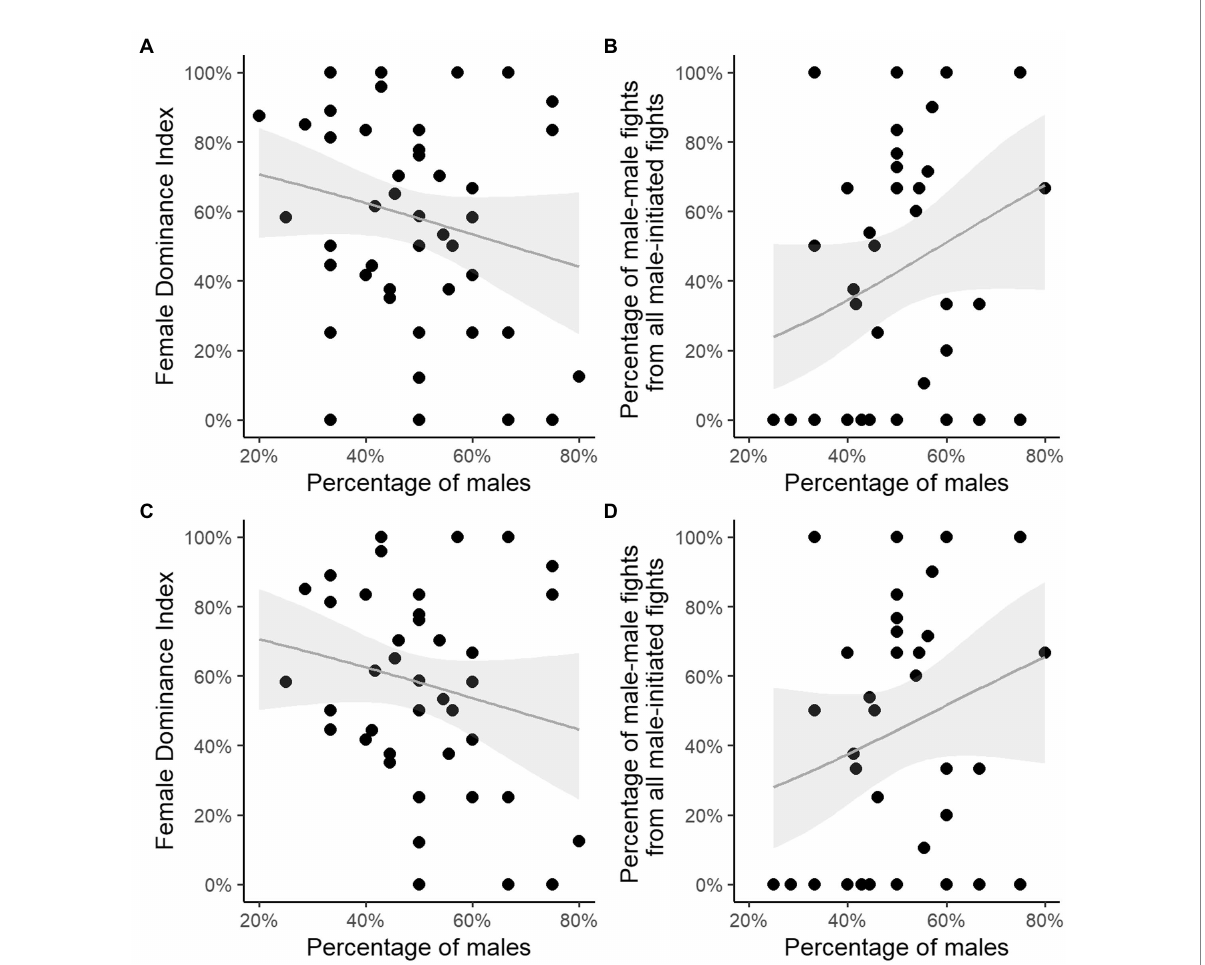
FIGURE 3 Percentage of resident plus bachelor males in groups with a single male or multiple males versus (A) Female Dominance Index; (B) percentage of male–male fights of male-all fights. Percentage of resident plus bachelor males in multi-male groups only versus (C) Female Dominance Index; (D) percentage of male–male fights of male-all fights. Grey line represents the fitted regression line, grey polygons represent the 95% confidence intervals. Note that some data-points overlap, see T able S3 for all